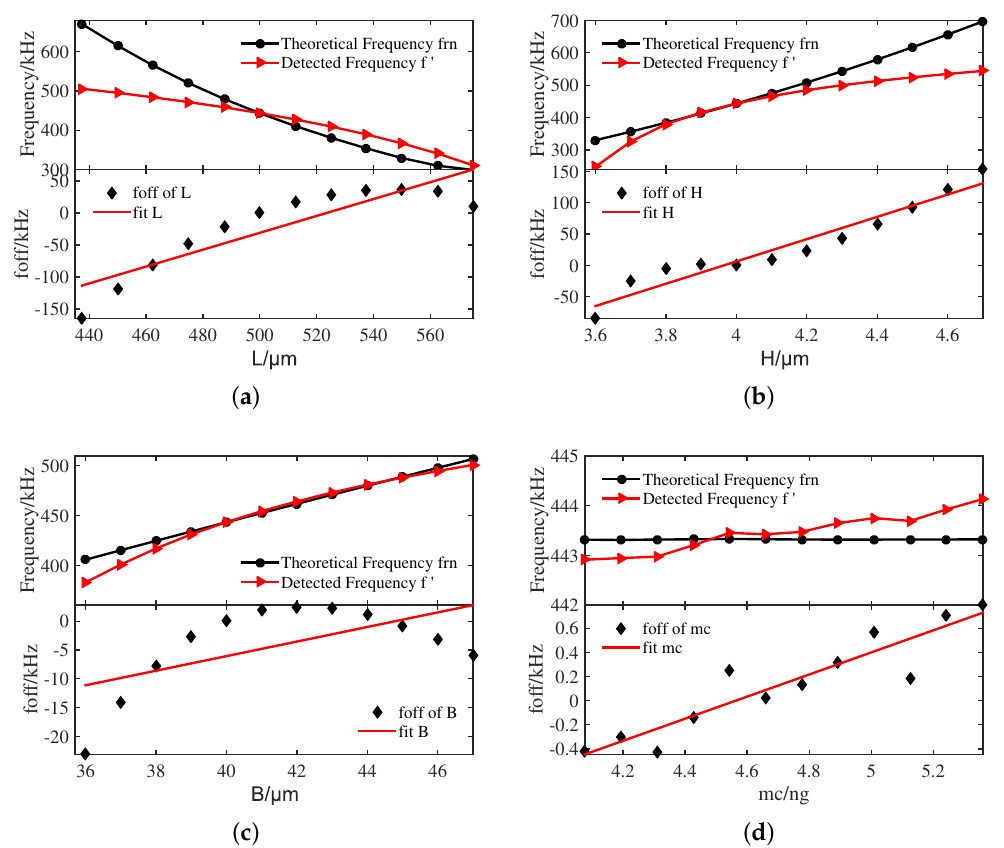
Figure 14. The experimental and theoretical results. ( a ) L, ( b ) H, ( c ) B and ( d ) m c